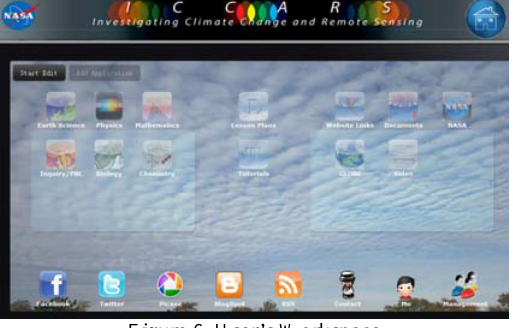
Figure 5. Functional Flow Chart of Server Synchronization